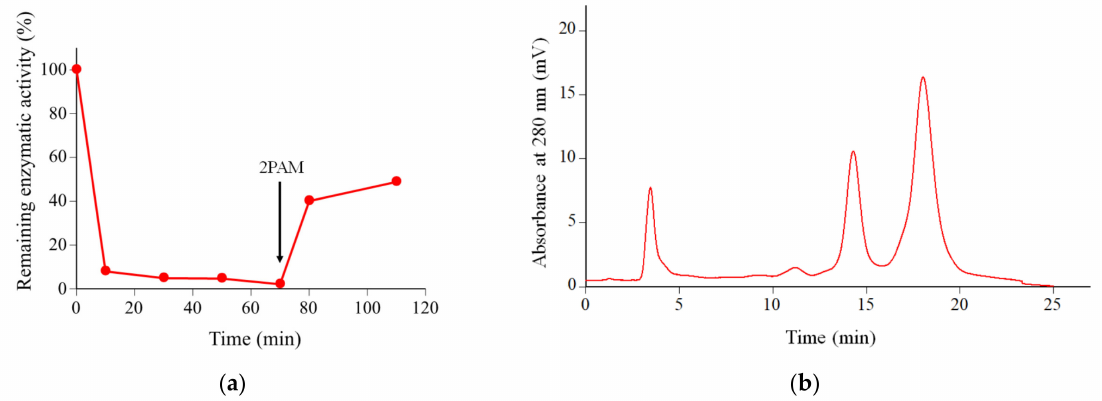
Figure 5. ( a ) Changes in the remaining enzymatic activity during the modification process by using two equivalents of DanD per Csin. The enzymatic activity was assayed by using Bz-Tyr- p NA dissolved in DMSO as a substrate. The final substrate concentration was 0.2 mM; ( b ) IEC profile for the product after 2PAM treatment from the modification by using 2 equivalents of DanD per Csin. The separation was performed on 3 connected HiTrap TM SP HP columns (7 mm I.D. × 25 mm) by using 50 mM sodium acetate buffer (pH 5.0) with a linear gradient of NaCl (0–0.5 M over 20 min).